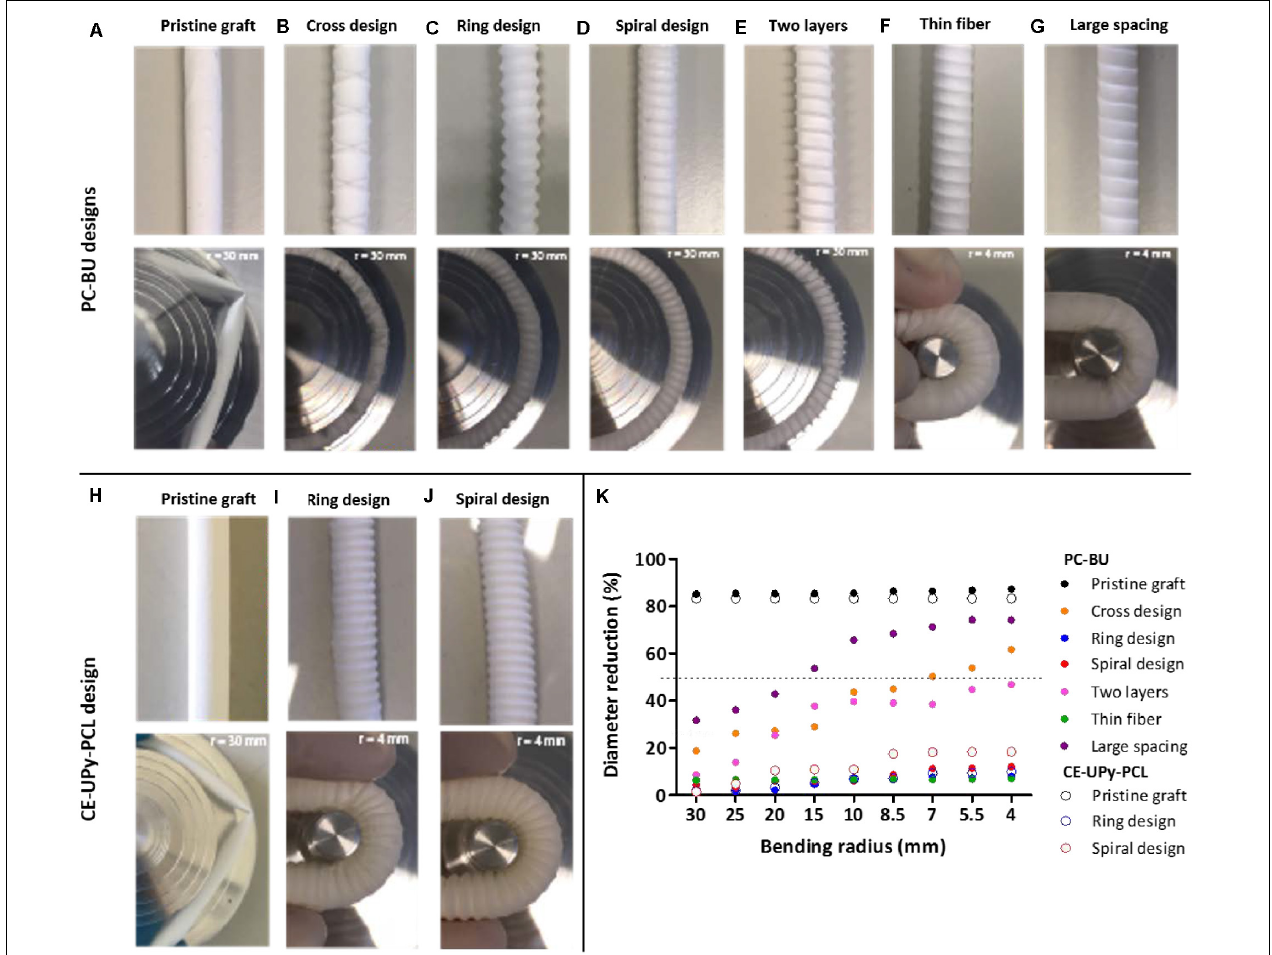
FIGURE 3 | Bending test on PC-BU and CE-UPy-PCL. (A–J) Vascular grafts with different anti-kinking architectures were designed and studied with a custom-made bending apparatus with a radius of 4–30 mm. (K) The percentual diameter reduction of the outer diameter is measured and plotted against the bending radius. Indication for anti-kinking behavior is defined at a diameter reduction less than 50% (marked with the dotted line).